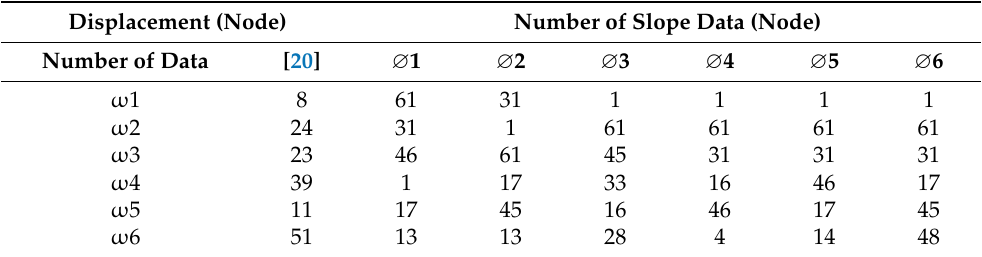
Table 6. Sensor location in the FEM model used for estimation (slope with displacement)—beam.